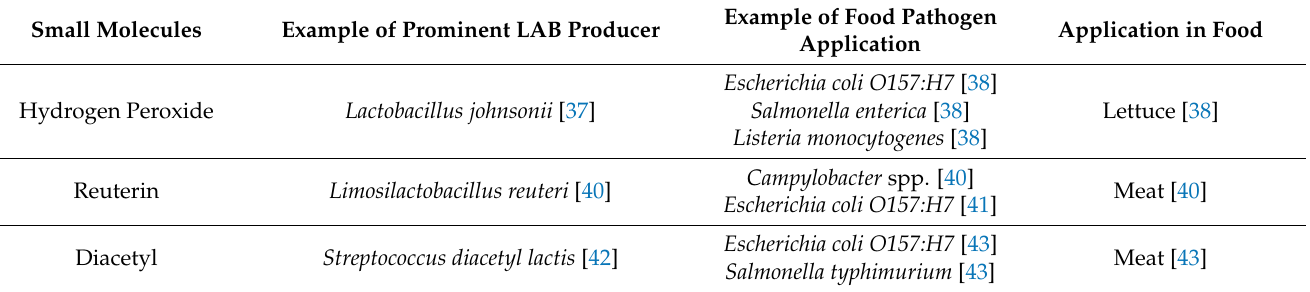
Table 3. Antimicrobial compounds produced by LAB and examples of food pathogens and food application. Small